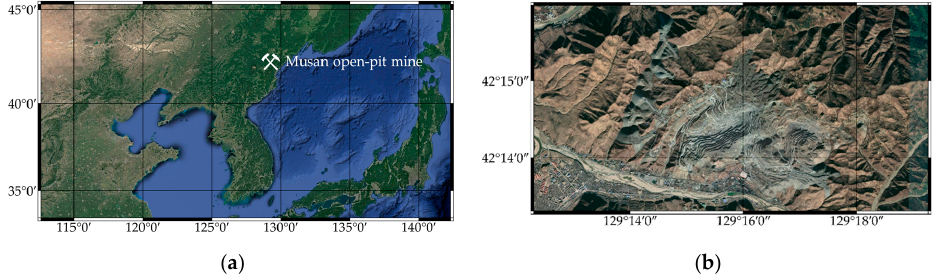
Figure 2. The study area, Musan open-pit mine, in ( a ) small scale and ( b ) large scale (image from Google Earth).